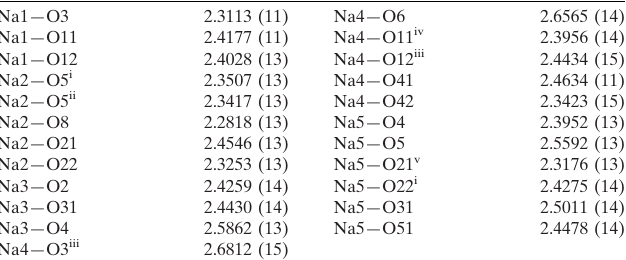
Selected bond lengths (A˚ ).